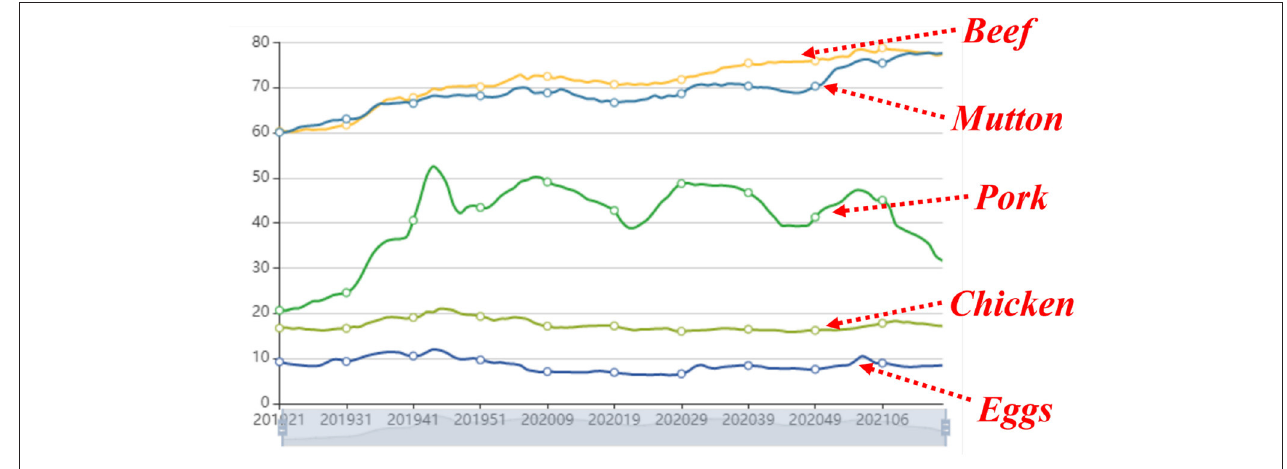
FIGURE 3 | The total tendency of market conditions concerning five types of agricultural